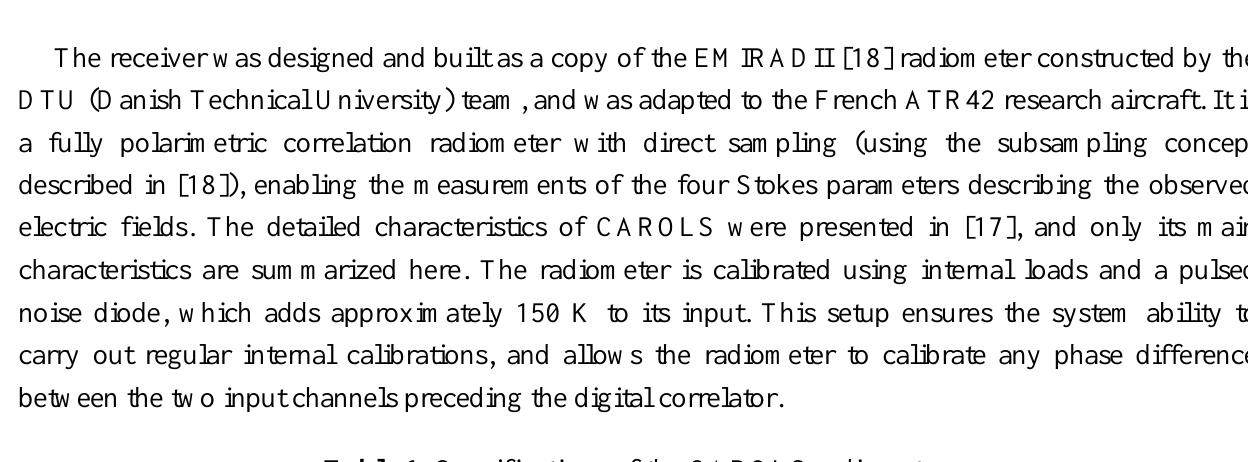
Table 1. Specifications of the CAROLS